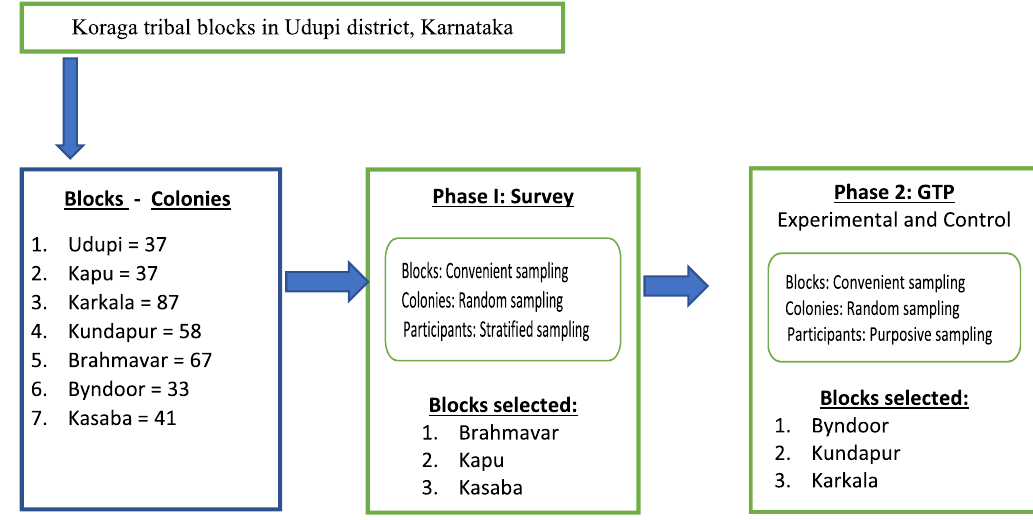
Figure 1. Schematic representation of sampling